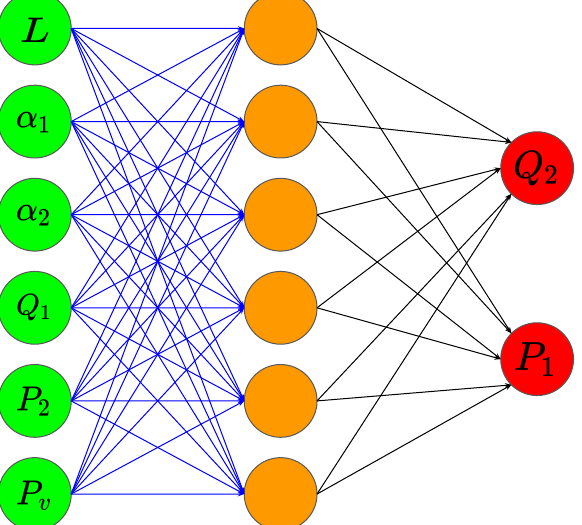
Figure 5. Architecture of the neural network modeling the LN drainage/filtration